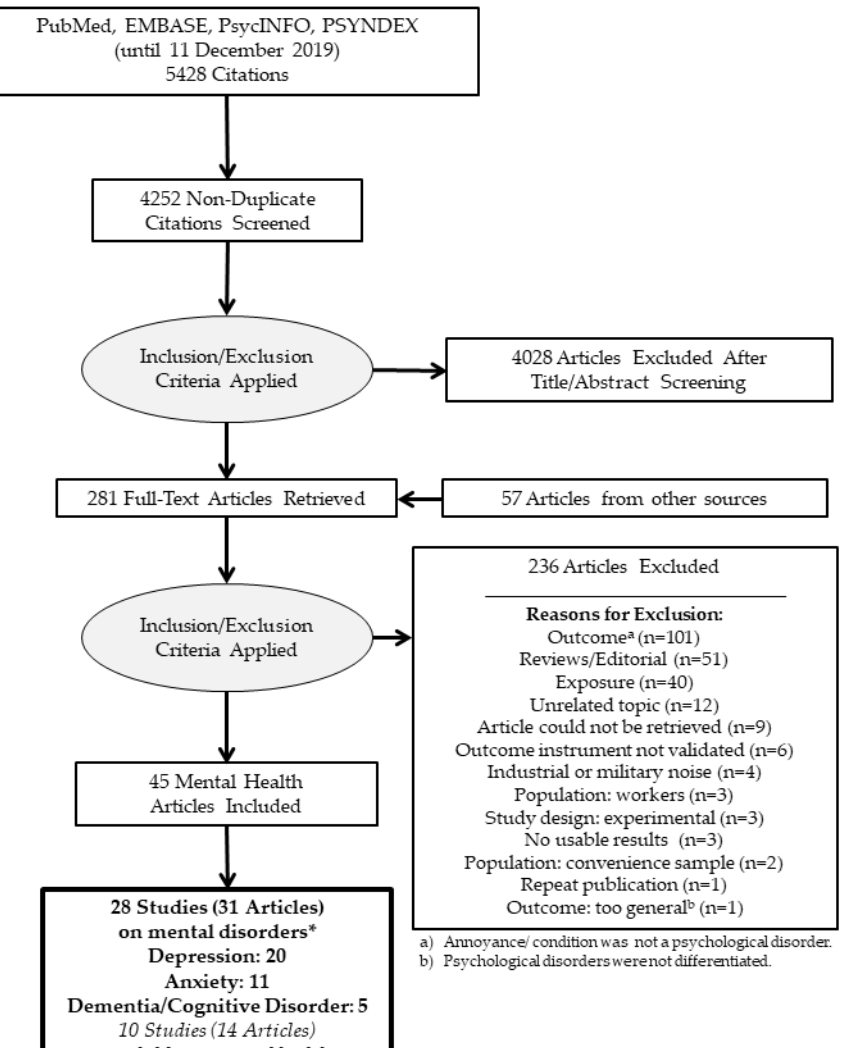
Figure 1. PRISMA flow diagram.